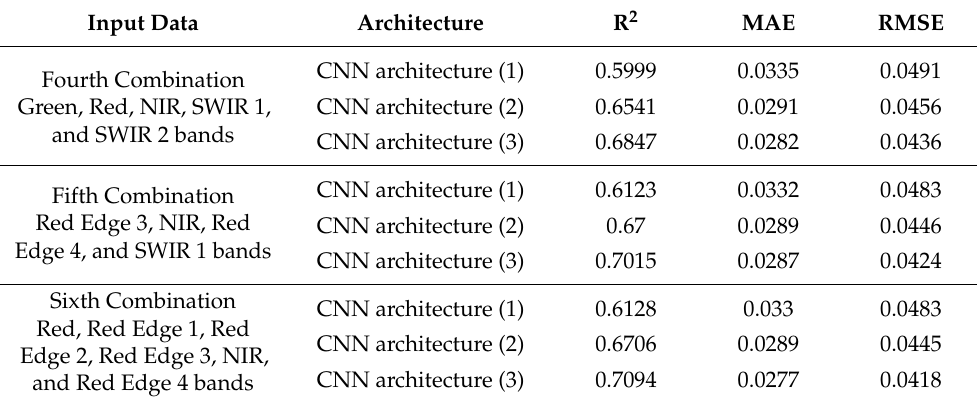
Table 2. Performance metrics of all